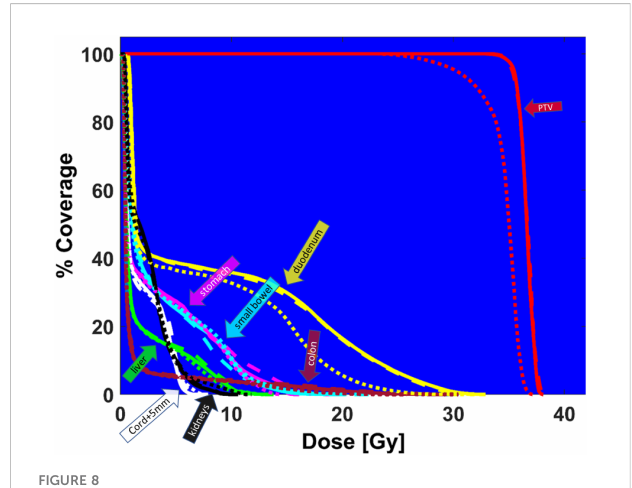
FIGURE 8 DVH comparison between ground truth plan (solid lines), predicted plan (large dashed lines), and reposition plan (small dashed lines) recalculated on daily MRI for PTV (red), duodenum (yellow), colon (magenta), cord + 5mm (white), liver (green), small bowel (cyan), stomach (pink), kidneys